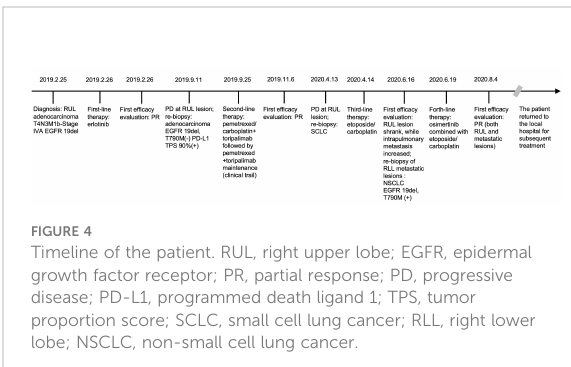
FIGURE 4 Timeline of the patient. RUL, right upper lobe; EGFR, epidermal growth factor receptor; PR, partial response; PD, progressive disease; PD-L1, programmed death ligand 1; TPS, tumor proportion score; SCLC, small cell lung cancer; RLL, right lower lobe; NSCLC, non-small cell lung